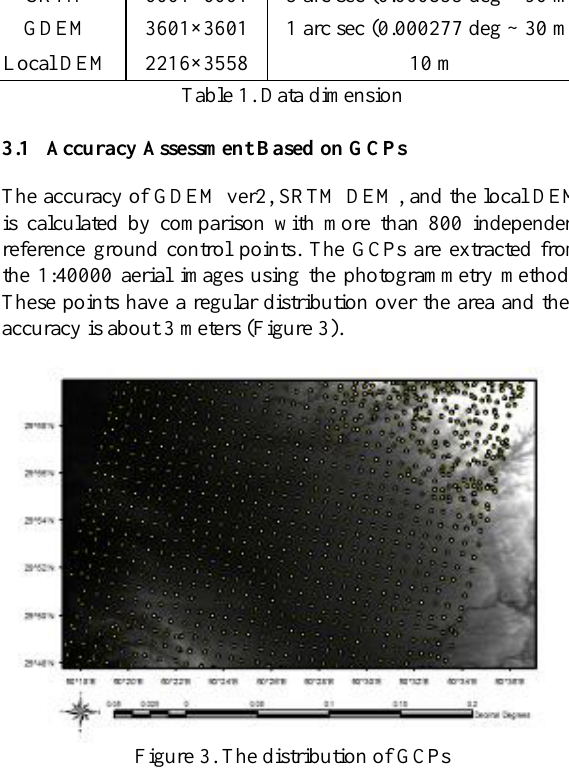
Figure 1. Study area in southwest of Iran